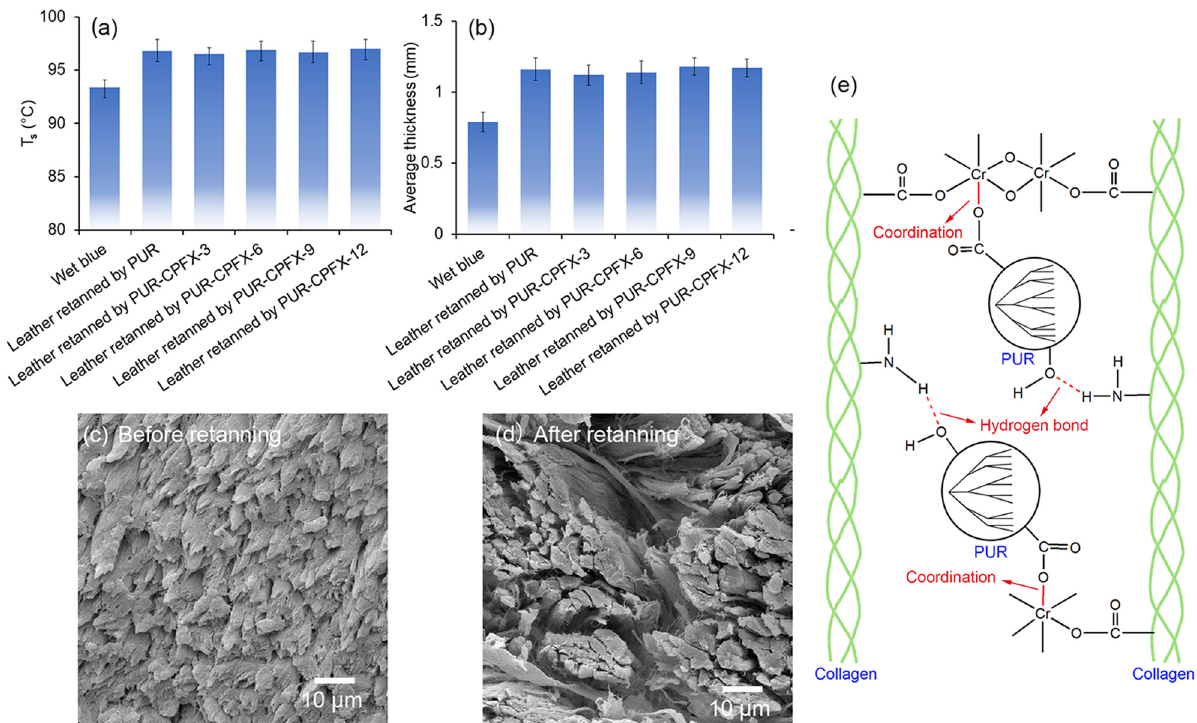
Figure 2: ( a ) T s , ( b ) average thickness of Wet blue and leather retanned by PUR and PUR - CPFXs. SEM images of leather ( c ) before and ( d ) after retanning. ( e ) Schematic diagram of retanning by